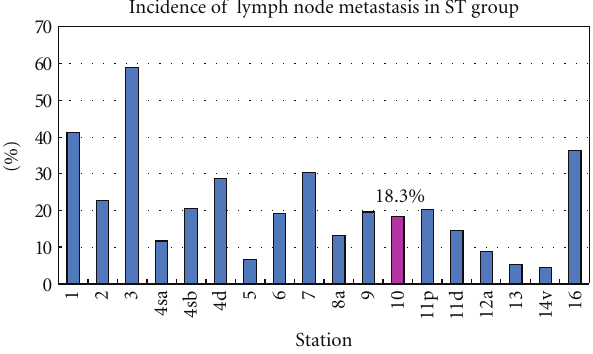
Figure 2: Incidence of each lymph node metastasis in ST